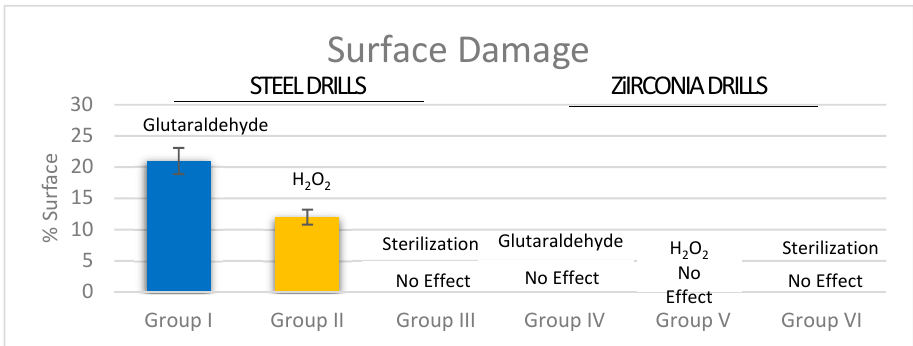
Figure 11. Differences in surface alteration occurred in the different study groups. Figure 13. Di ff erences in surface alteration occurred in the di ff erent study